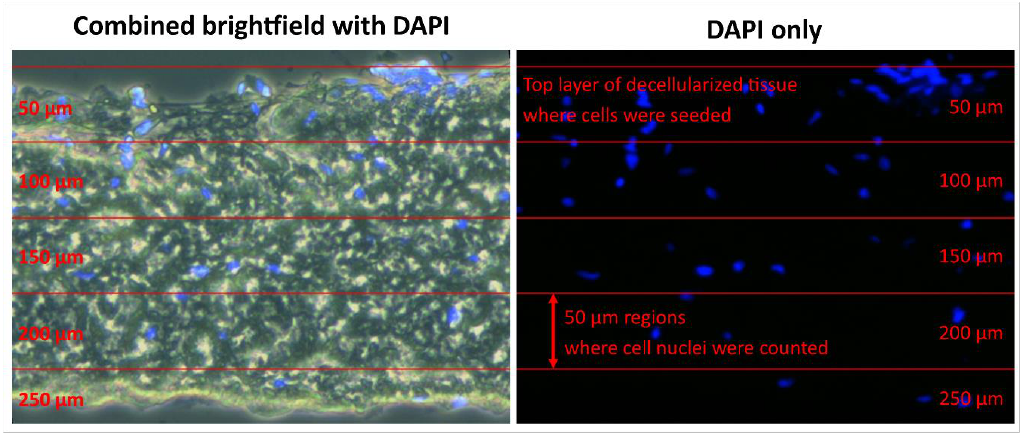
Figure 5. Example of slicing an image into 50 µm regions used for cell counting. The original images have been cropped to maintain the same area for analyzing multiple samples.